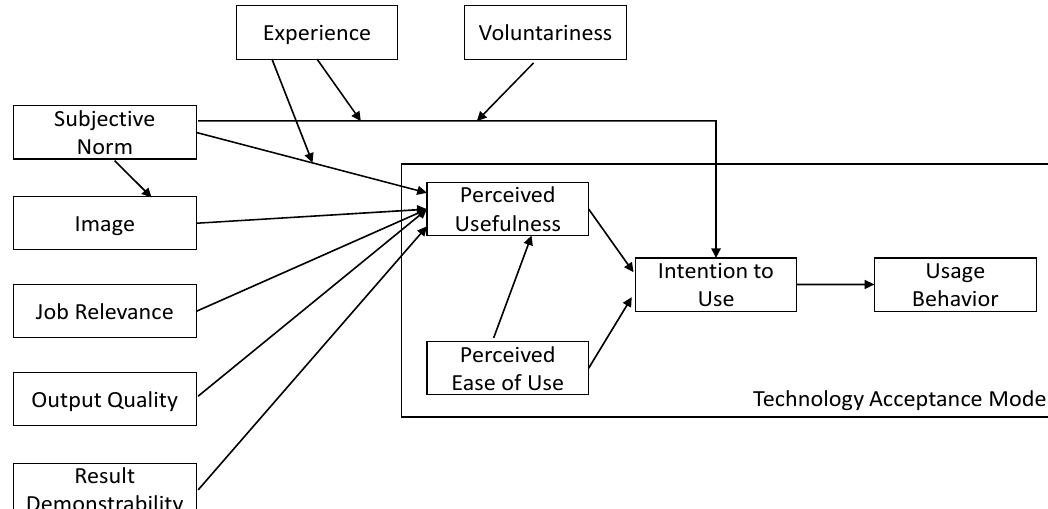
Figure 1. Expanded technology acceptance model (TAM) based on Venkatesh and Davis [28].